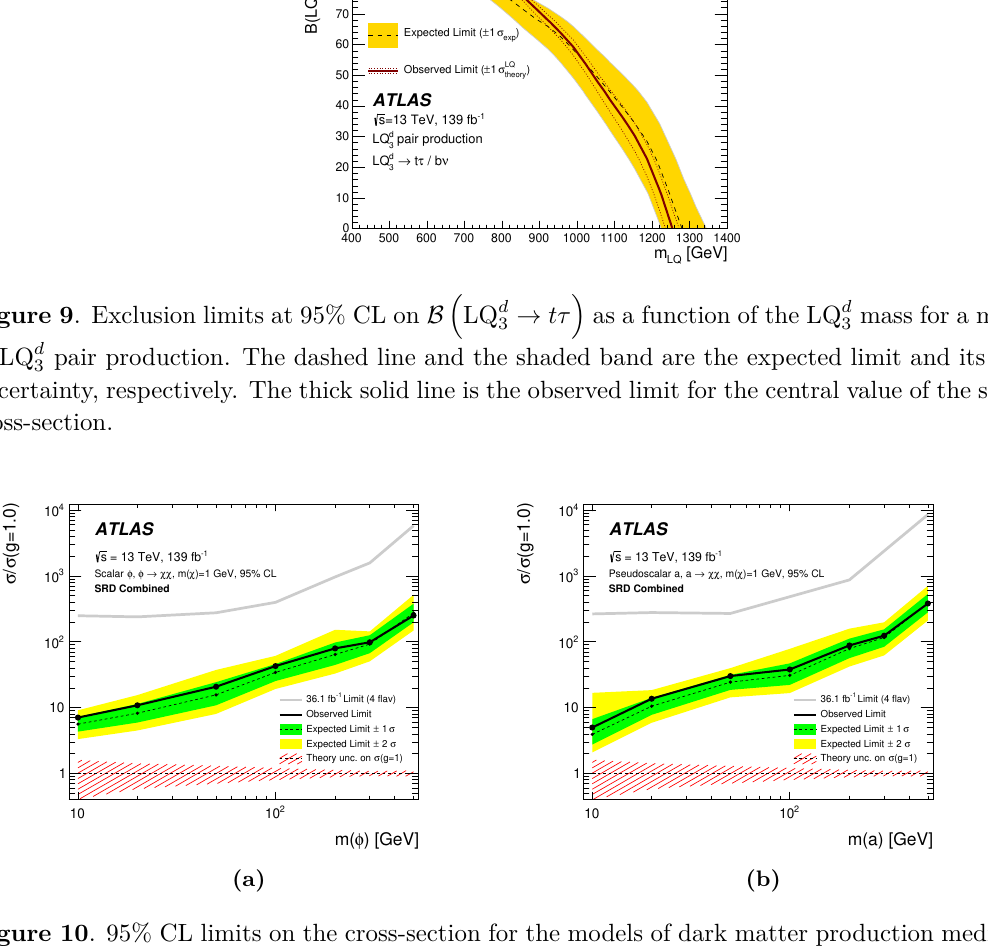
Figure 10 . 95% CL limits on the cross-section for the models of dark matter production mediated by a (a) scalar or (b) pseudoscalar mediator. The dashed line and the shaded band are the expected limit and its ± 1 σ and ± 2 σ uncertainties, respectively. The thick solid line is the observed limit for the central value of the signal cross-section. The grey line shows the limit from previous results [44]. The hatched red band shows the uncertainty of the model